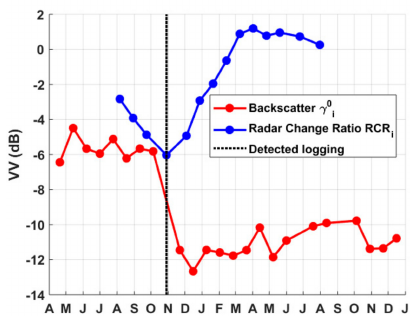
Figure 9. Time series of the backscatter (red) and the corresponding RCR (blue) over a 20-pixel area where a new shadow appears. The detected logging date (black dashed line) corresponds to the date when the RCR is minimum.